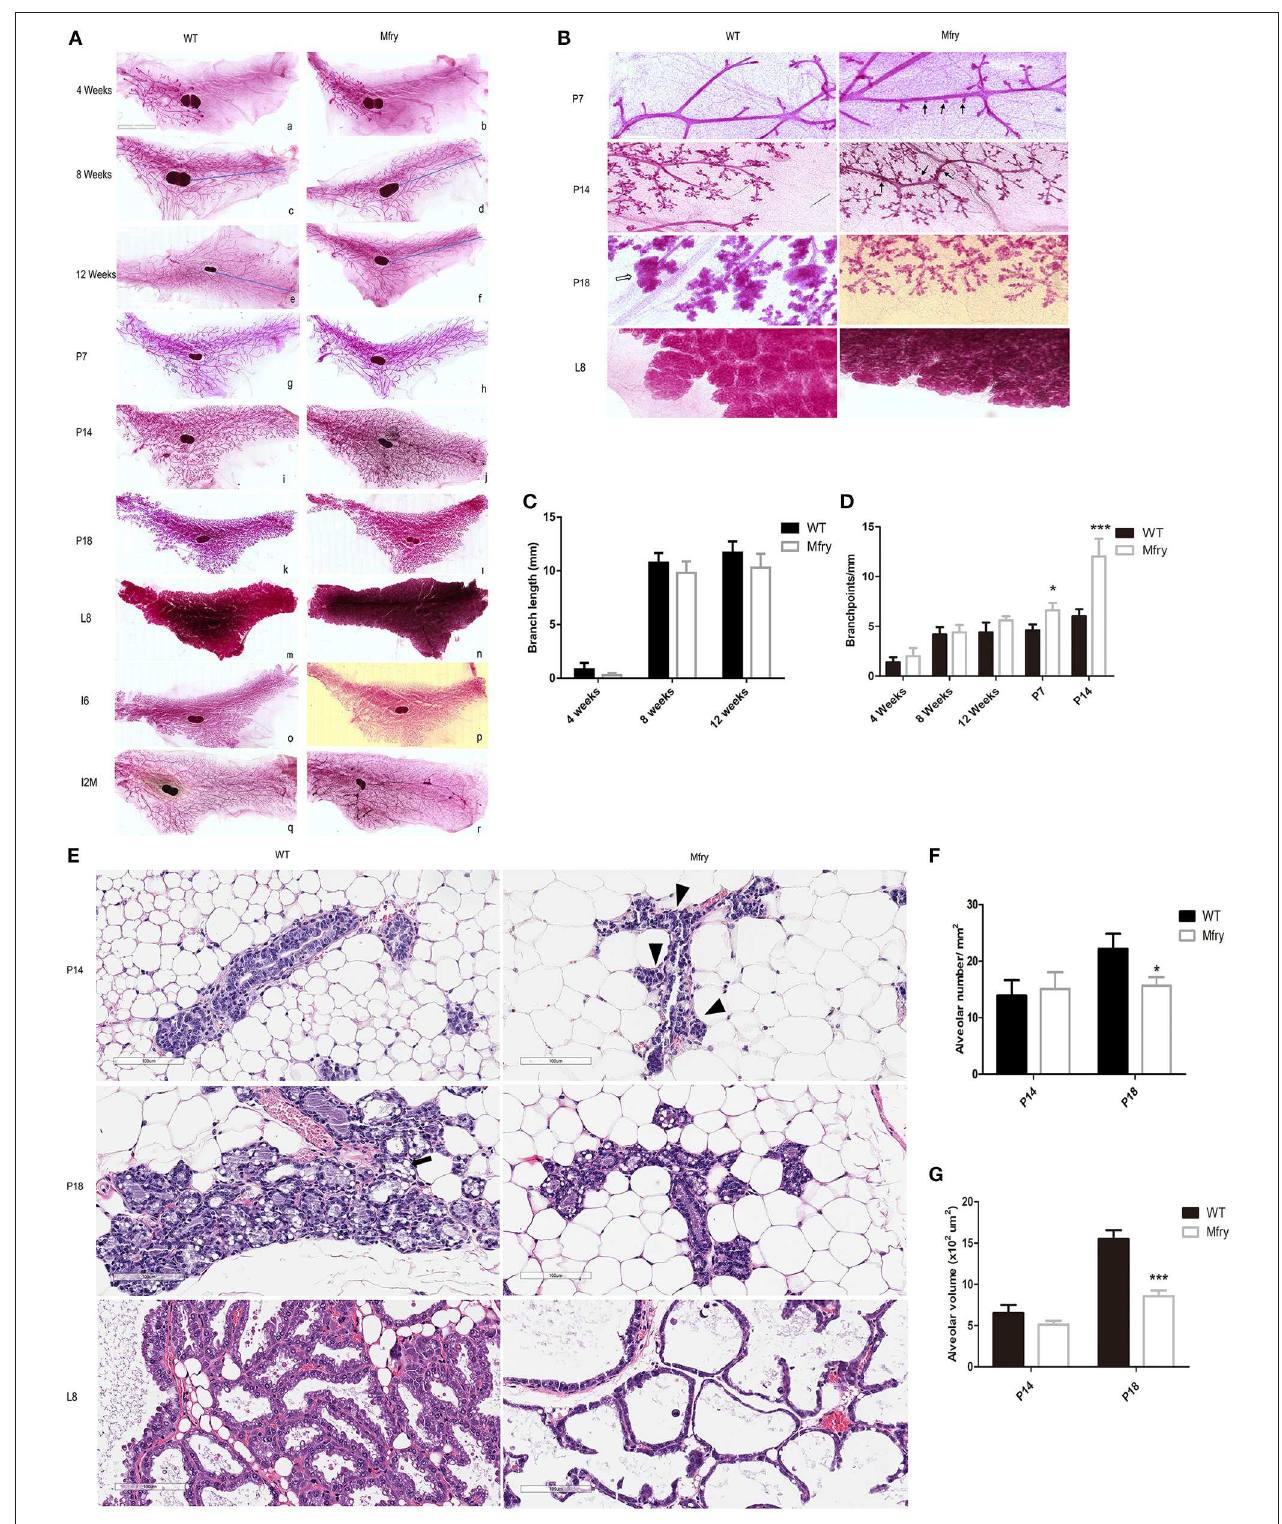
FIGURE 3 | Impaired development in Mfry mammary glands. (A,B) Whole-mount staining of WT and Mfry mammary glands. Low-magnification view of mammary glands from several developmental phases, including ductal elongation in the virgin gland at 4 weeks (a,b), 8 weeks (c,d), and 12 weeks (e,f), proliferation, differentiation, and the formation of lobuloalveolar structures during pregnancy at 7 days (P7) (g,h), 14 days (P14) (i,j), and 18 days (P18) (k,l), lactation 8 days (L8)